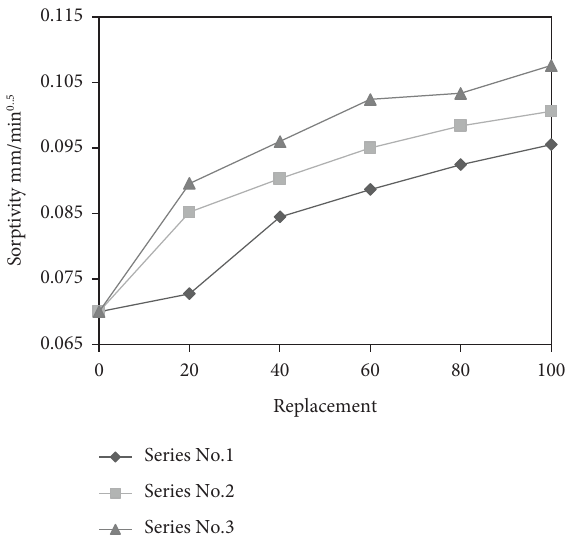
Figure 9: Water sorptivity variations of SCBGCs.